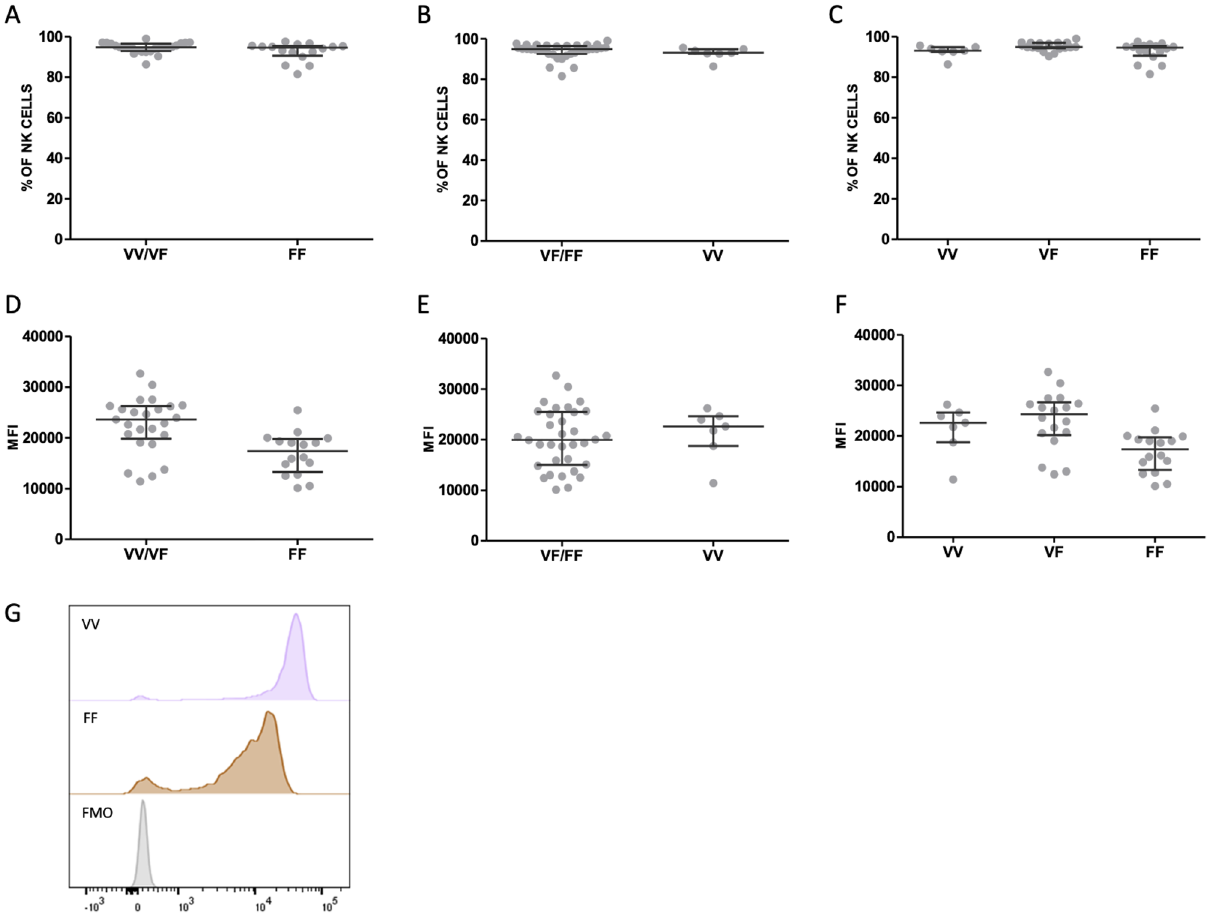
Figure 3. CD16a expression on NK cells in women with RPL genotyped for CD16a. Percentage of CD16a positive cells of total CD3 negative CD56 positive NK cells ( A / B / C ) and MFI ( D / E / F ) normalized by FMO of CD16a expression measured by flow cytometry in women with at least one valine (VV/VF) versus (FF) FCGR3A -p.176 genotypes ( A and D ) or at least one phenylalanine allele (VF/FF) and (VV) genotypes ( B and E ) or VV, VF and FF genotypes ( C and F ). Dots depict individuals, lines depict median and interquartile range per group, * P < 0.05. Representative histogram of CD16a expression on NK cells (G) depicting FMO (no anti-CD16a) in grey and CD16a expression for the (VV) genotype in purple and the (FF) genotype in